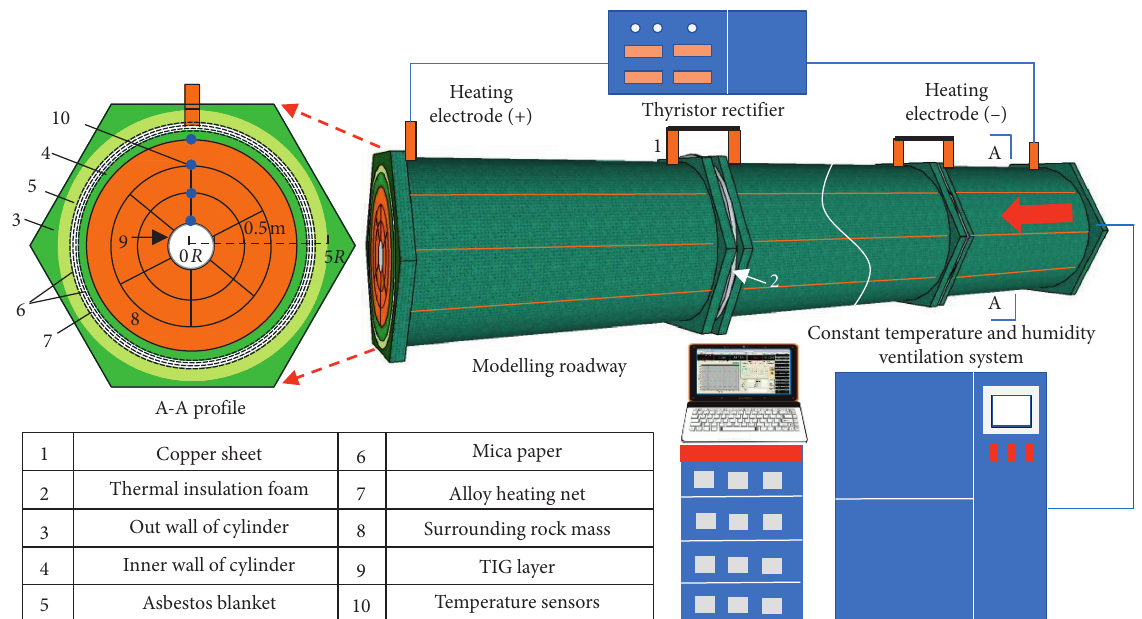
Figure 2: Schematic diagram of the experimental apparatus.